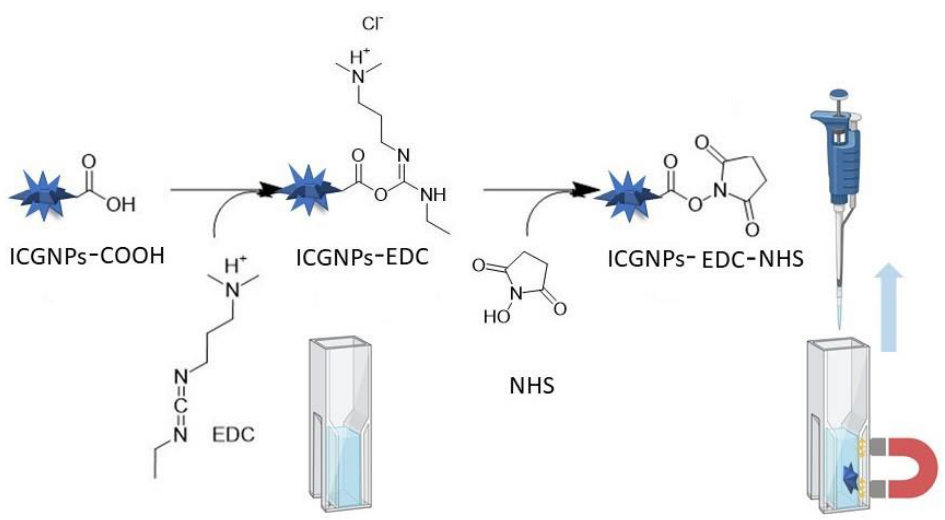
Figure 1. Schematic representation of conjugation of ICGNPs in a cuvette. NHS and EDC can react with ICGNP – COOH to form IGGNP – EDC-NHS. IGGNP – EDC-NHS can then be removed from the suspension by a magnet applied to the external surface. IGGNP – EDC-NHS provides the amide to connect with antibody.